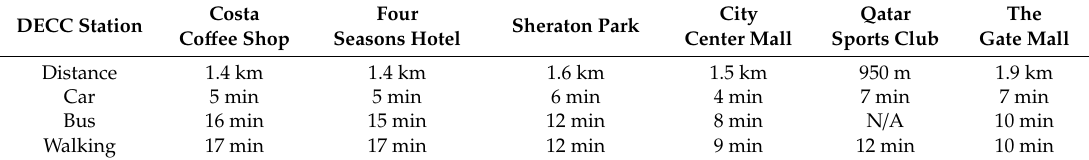
Figure 9. ( a ) Pedestrian, parking, and cycling map in West Bay; ( b ) transportation map in West Bay; ( c ) bus shuttle routes map in West Bay (source: the Ministry of Transportation and Ministry of Municipality and Environment in Qatar).